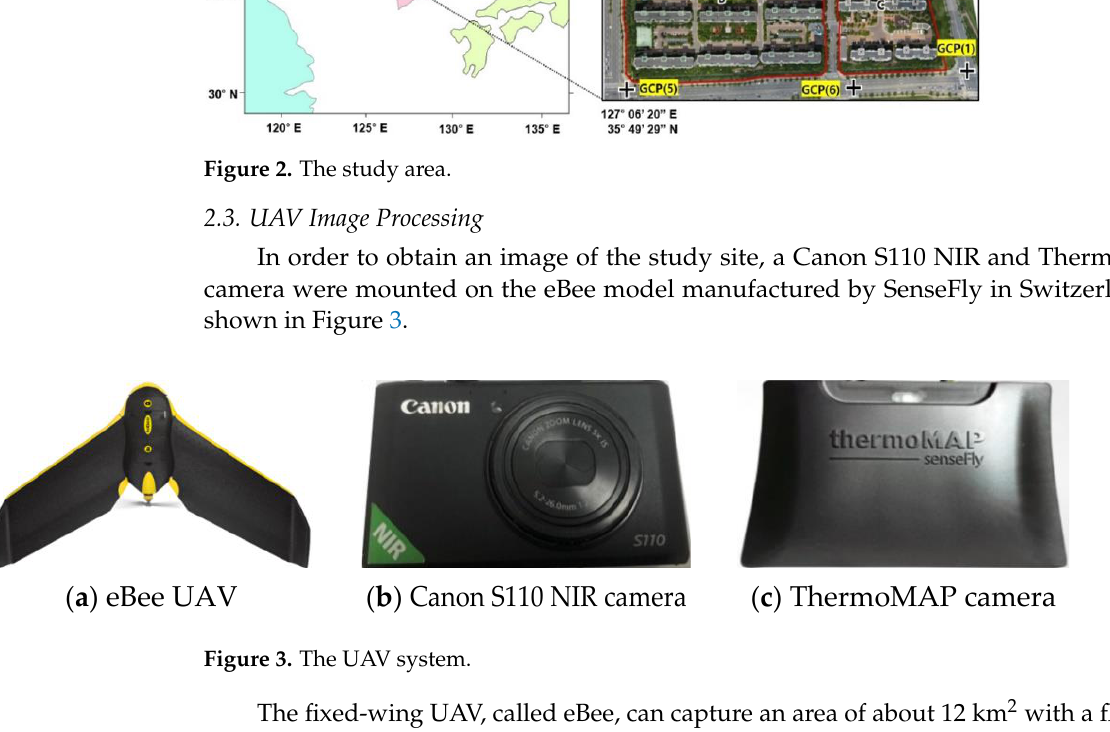
Figure 2. The study area.